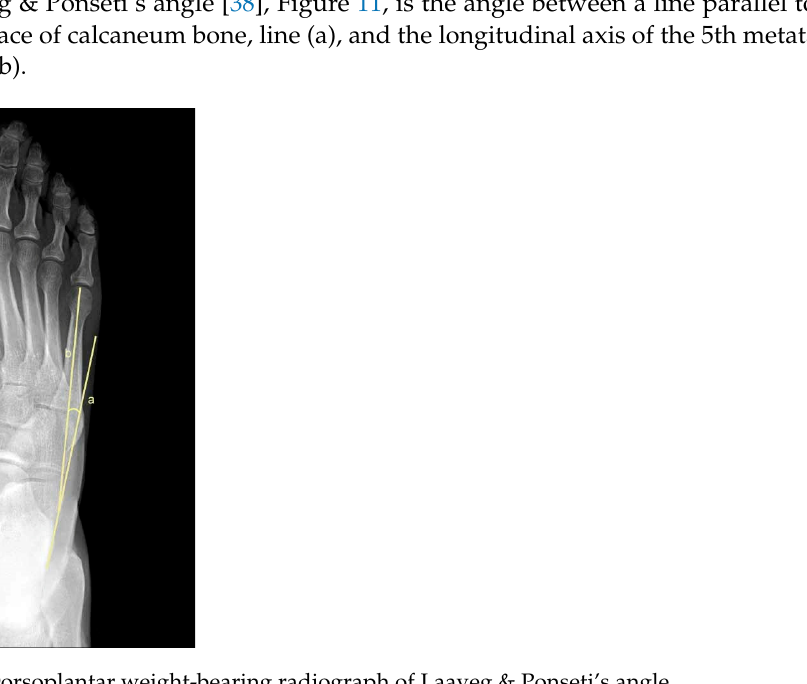
Figure 11. Dorsoplantar weight-bearing radiograph of Laaveg & Ponseti’s angle.